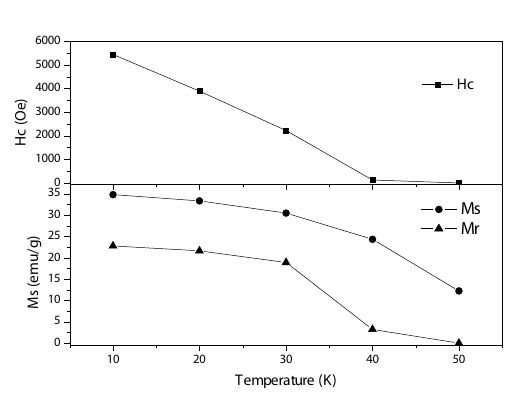
Figure 6. Temperature dependence of coercive field, saturation magnetization and remanent magnetization for sonochemically synthesized Mn